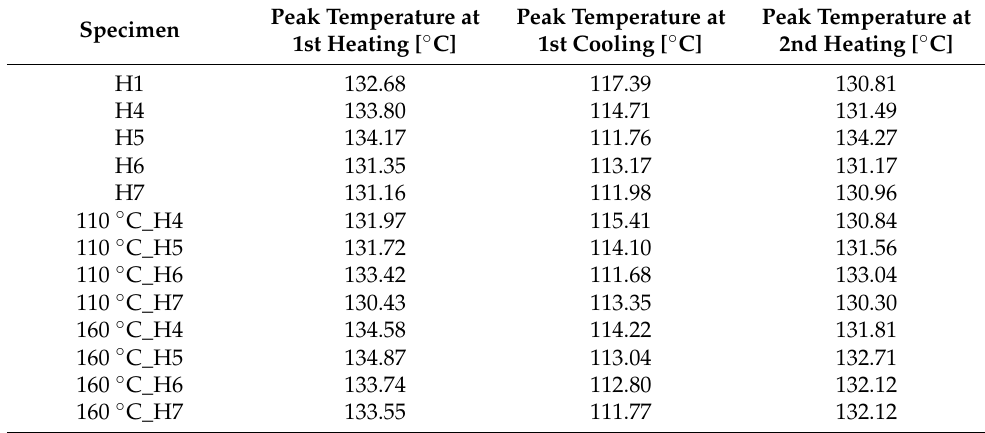
Table 4. Evaluated data from DSC.